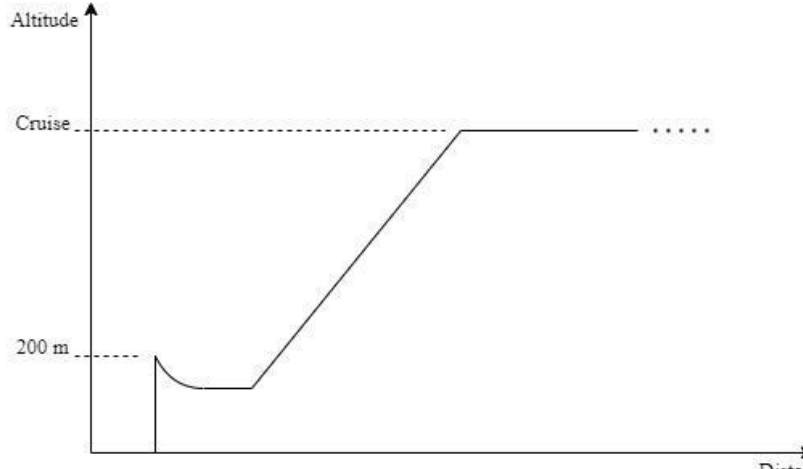
Figure 2. A diagram of the vertical take-off and the further climbing as fixed-wing UAV until the cruise altitude.